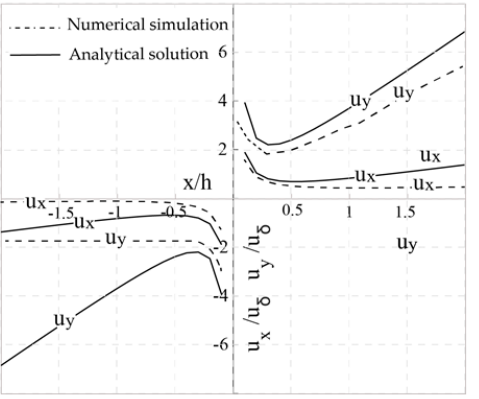
Figure 22. Comparative analysis between the analytical solution and the numerical simulation.